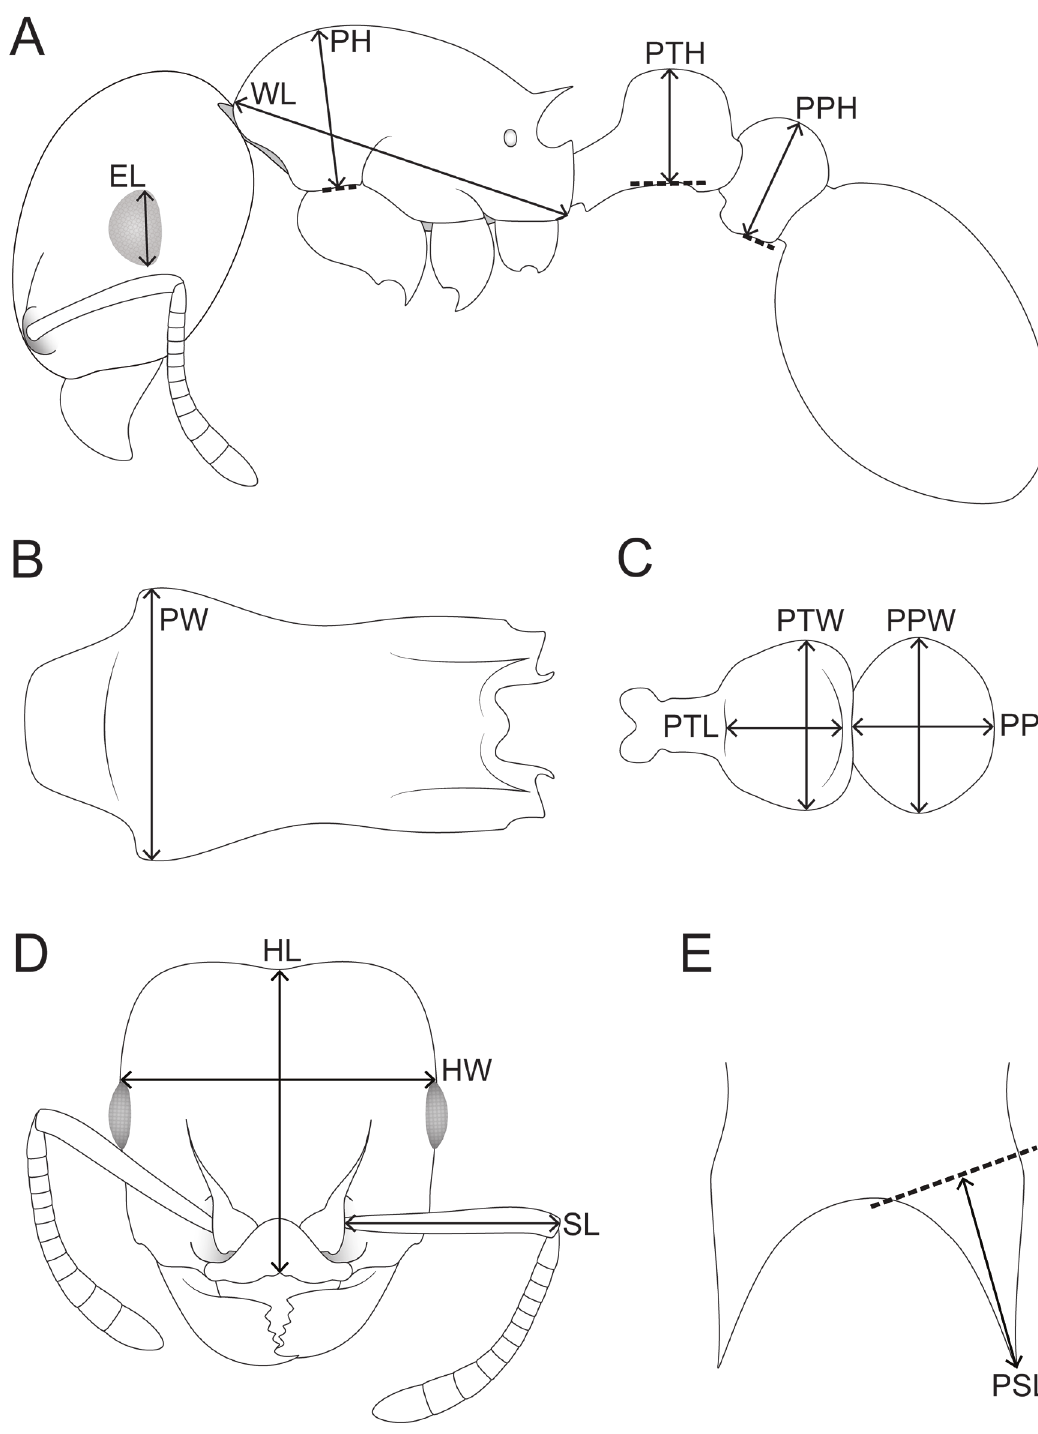
Fig. 1. Schematic line drawings of a T. solidum group species illustrating the used measurements. A . Body in profile with measuring lines for EL, WL, PH, PTH and PPH. B . Mesosoma in dorsal view with measuring line for PW. C . Petiole and postpetiole in dorsal view with measuring lines for PTL, PTW, PPL and PPW. D . Head in full-face view with measuring lines for HL, HW and SL. E . Dorsocaudal view of the propodeum with measuring line for